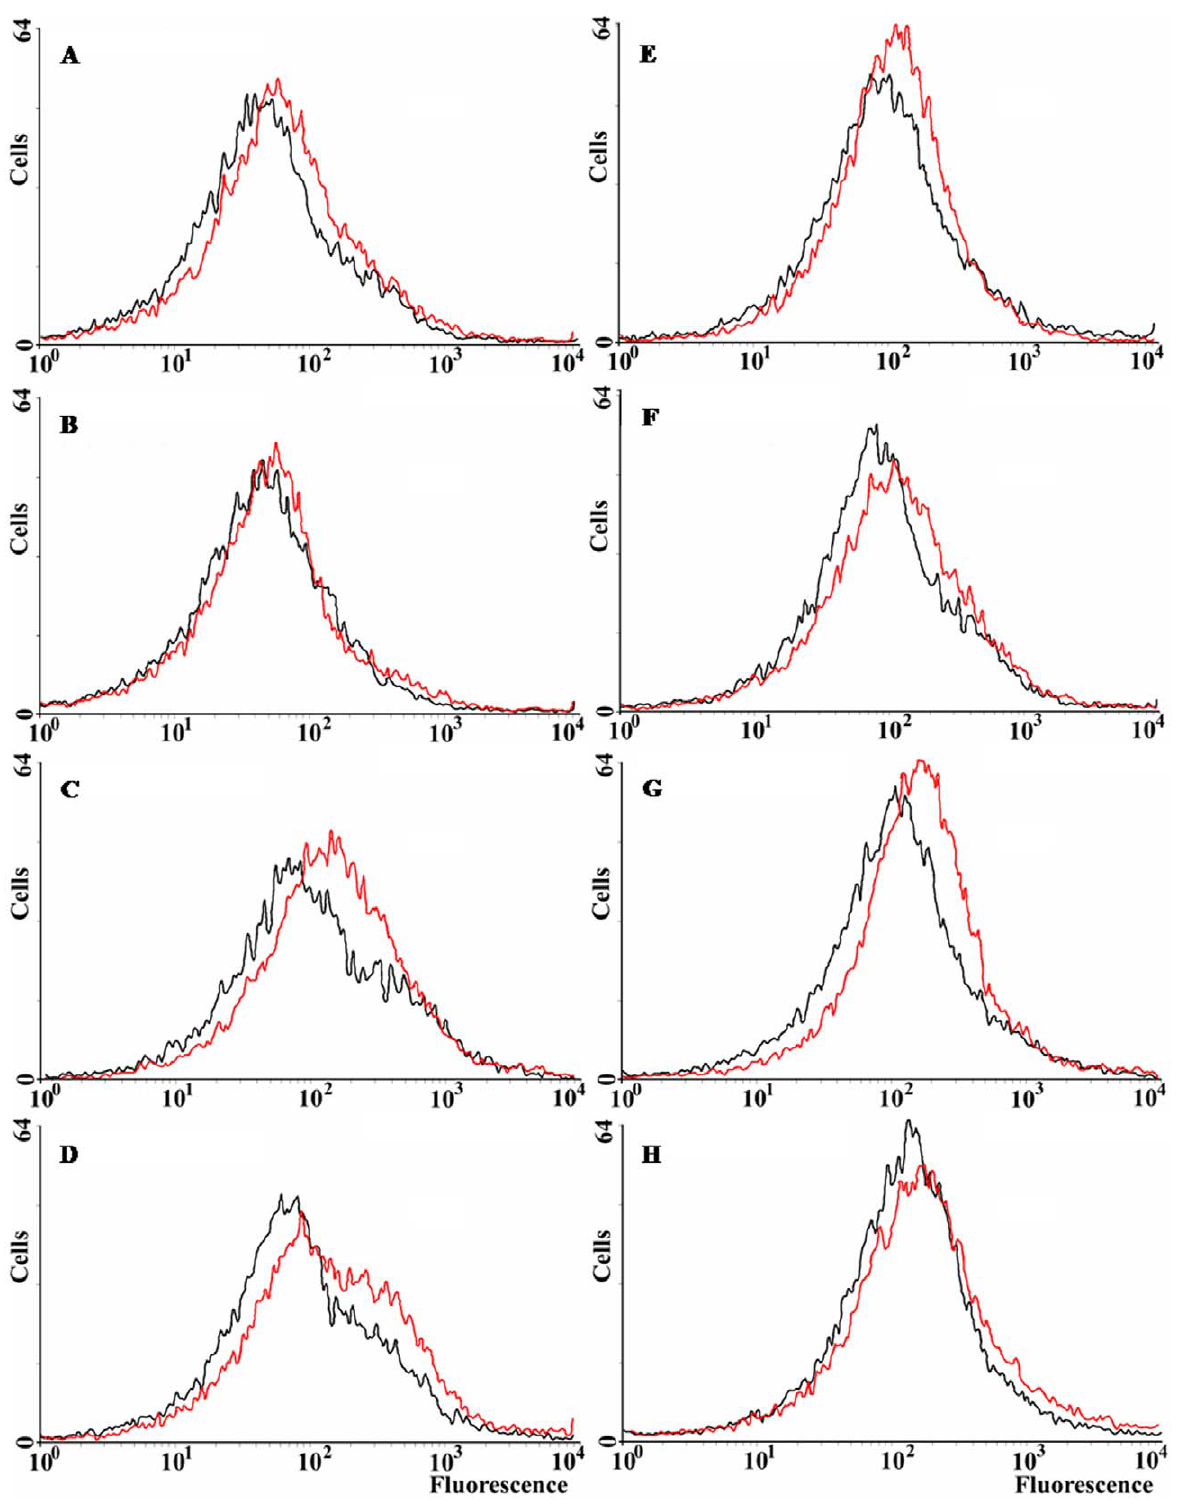
Figure 4. ROS levels in E.coli wild-type and norM , mutT and sodB derivatives. Representative histograms plotting the spontaneous fluorescence of 15,000 non-treated (A–D) and H 2 O 2 -treated (E–H) cells, revealed by DHR, as measured by flow cytometry. Cells containing either the empty vector or the norM -containing plasmid are represented as red or black lines, respectively. A and E: wild-type strain (non treated and H 2 O 2 - treated, respectively); B and F: norM -deficient strain; C and G: mutT -deficient strain; D and H: sodB -deficient strain.